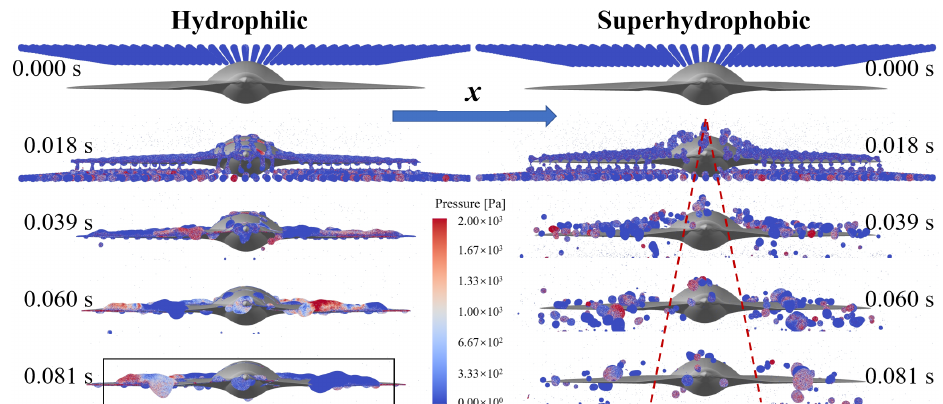
Figure 8. Comparison of the effects of surface curvature and wettability on lateral-pressure distribution. Water adhering to the hydrophilic surfaces of the wings quickly creates areas of high pressure on the wings, but asymmetrically, which induces nonequilibrium mechanical flight penalties. However, the coupling of superhydrophobicity to the surface curvature can disperse the impact force, no obvious high-pressure region is observed on the superhydrophobic surface, and the lateral interference is thus weakened (see details in “Supporting Movie S5” and “Supporting Movie S7” in the Supplementary Material).